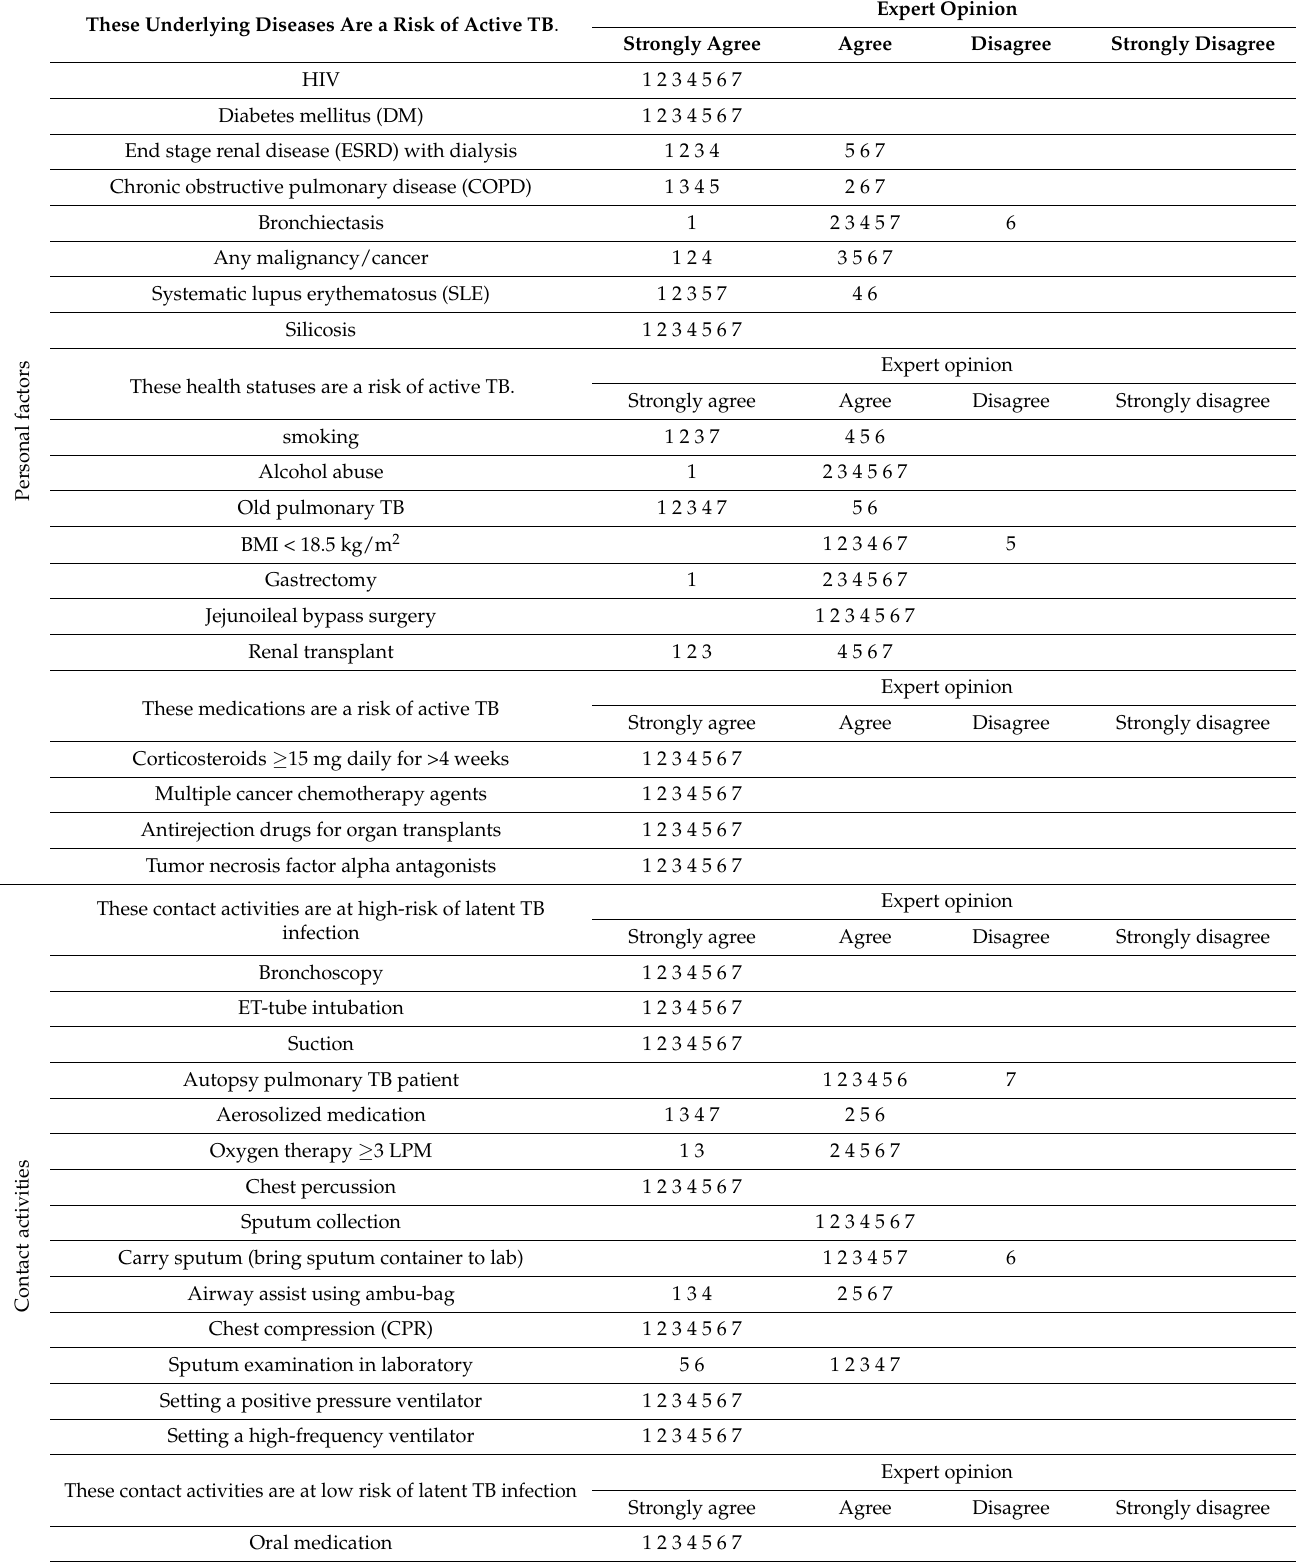
Table A3. I-CVI and S-CVI/Ave formula and calculation